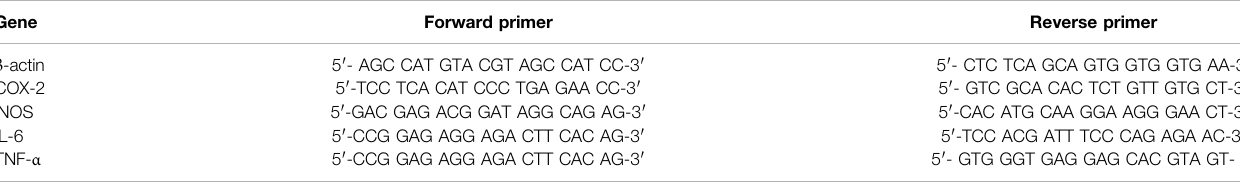
TABLE 1 | Mouse Primers for qPCR. Gene Forward primer Reverse